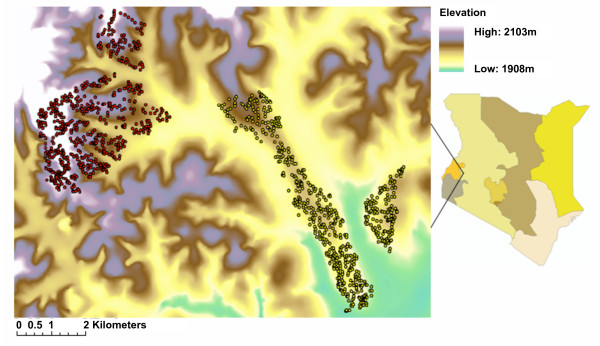
Elevation map of Kipsamoite and Kapsisiywa. Digital terrain map of Kipsamoite (red) and Kapsisiywa (yellow) located in Nandi District in the western Kenyan highlands. Kipsamoite elevation is higher and more variable than Kapsisiywa. Colours in the map of Kenya at right depict provinces.